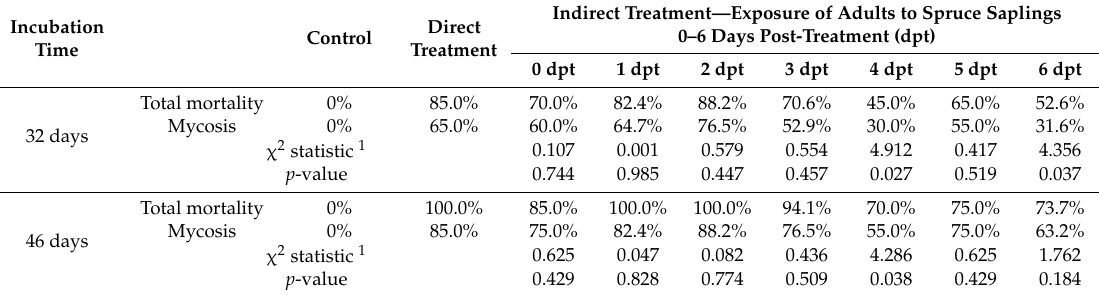
Table 4. Mortality of H. abietis adults after their direct and indirect treatment with conidia of the most virulent Beauveria bassiana strain AMEP20 in outdoor